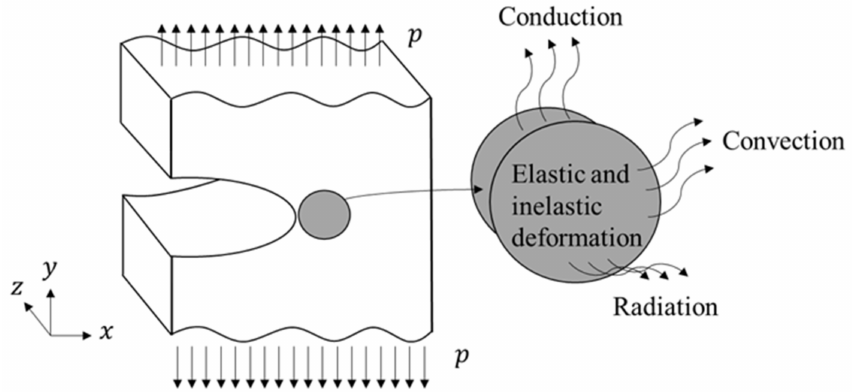
Figure 3. Thermomechanical exchanges at the crack tip. The externally applied force is converted into elastic and inelastic (plastic) deformation, in which the resulted heat is exchanged with the environment under convection, radiation, and